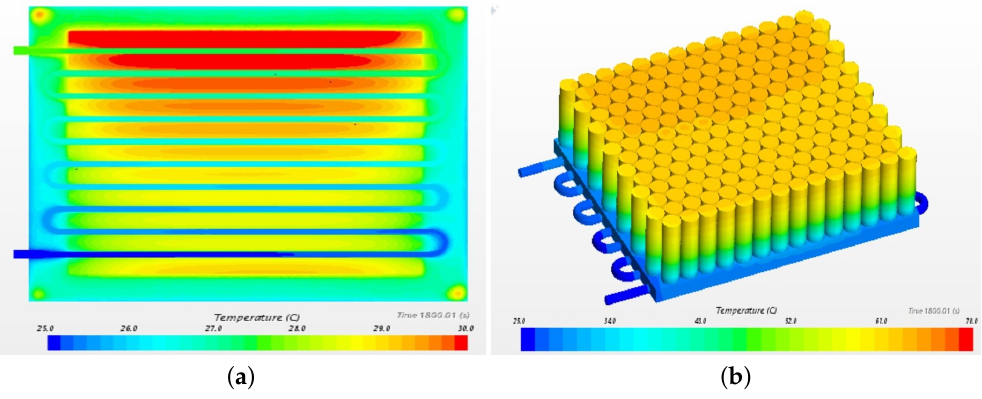
Figure 7. Contours of temperature in (°C) ( a ) along the vertical mid-plane through the cold-plate copper tube, and ( b ) on all the Li-ion cells within the cold-plate-cooled module. These results for the temperatures clearly show an improved thermal performance with respect to the average and maximum temperatures of the cells in battery